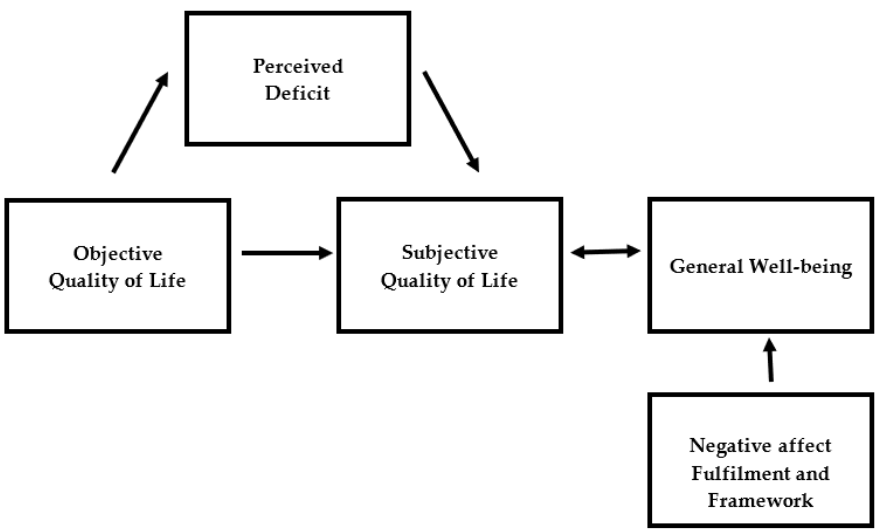
Figure 1. Operationalisation of Cummins’ model using variables of the Lancashire Quality of Life Profile (LQoLP).